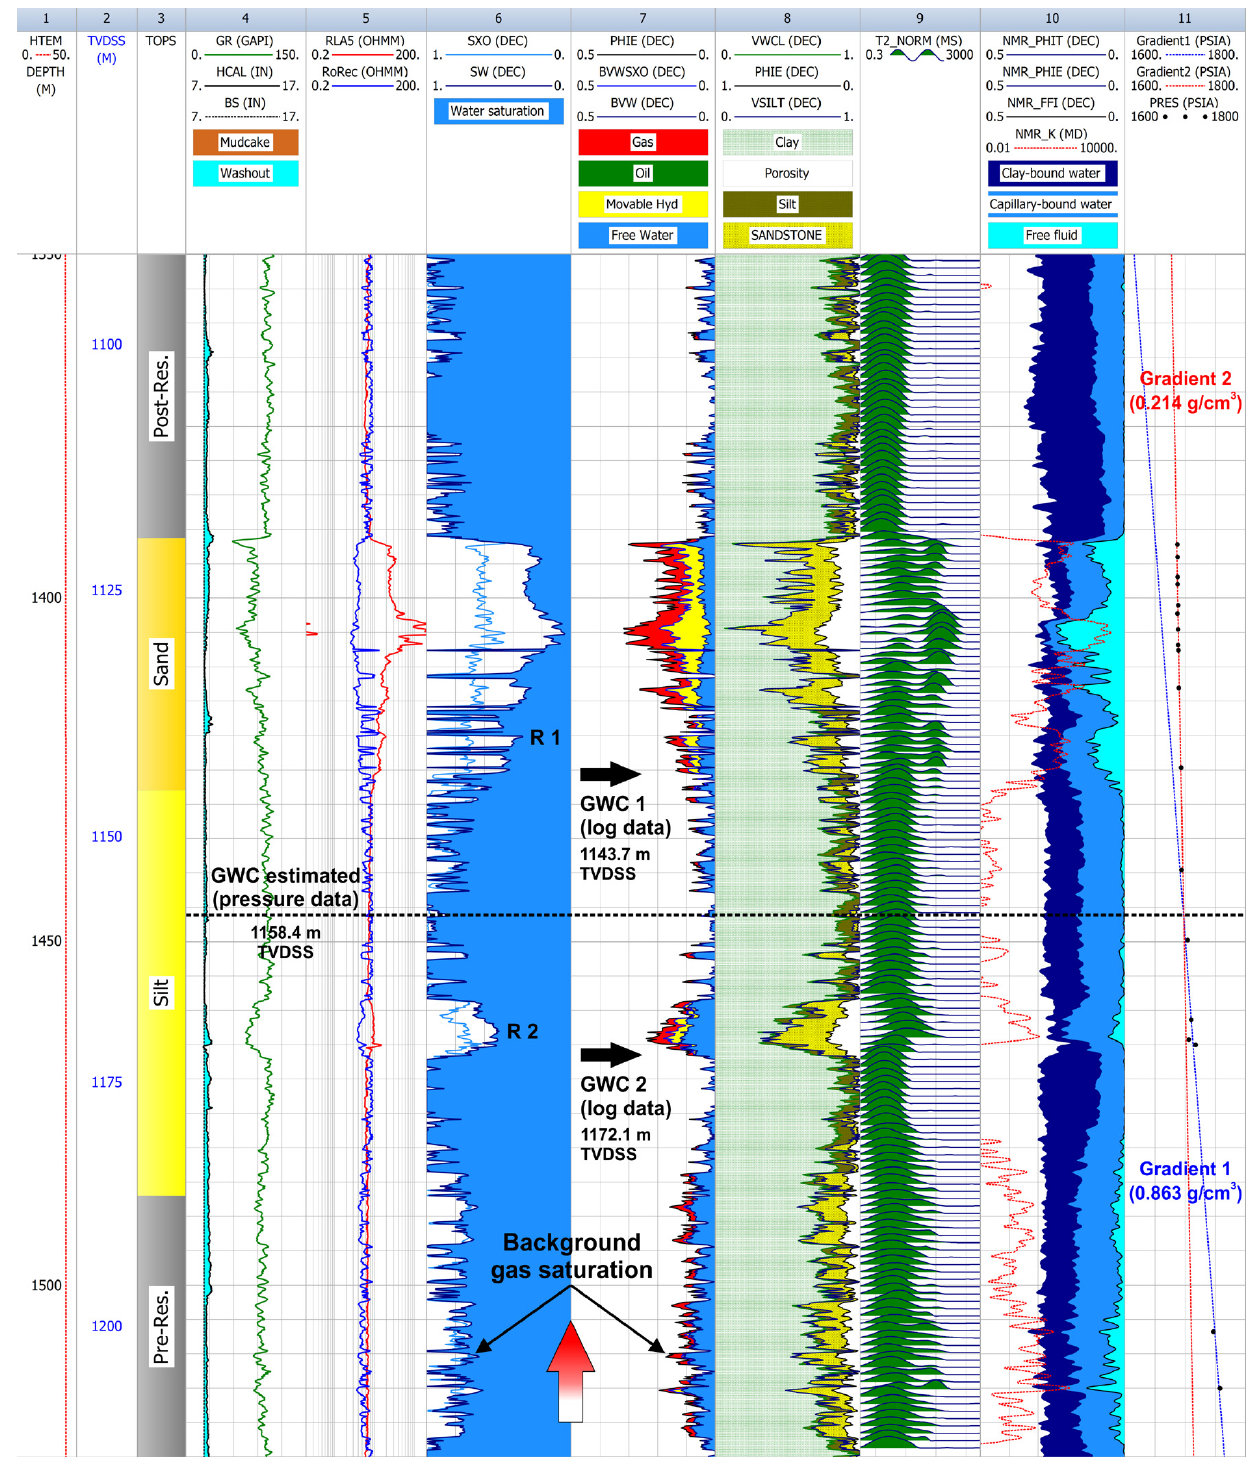
14 Figure 14. Example of deterministic log interpretation results for well A-2. HTEM —borehole temperature, GR —gamma-ray intensity, HCAL —caliper, BS —bit size, RLA5 —deep Laterolog apparent resistivity, RoRec —reconstructed R 0 resistivity, SW —uninvaded zone water saturation, SXO —flushed zone water saturation, PHIE —effective porosity, BVW —uninvaded zone bulk volume of water, BVWSXO — flushed zone bulk volume of water, VWCL —wet clay volume, VSILT —silt